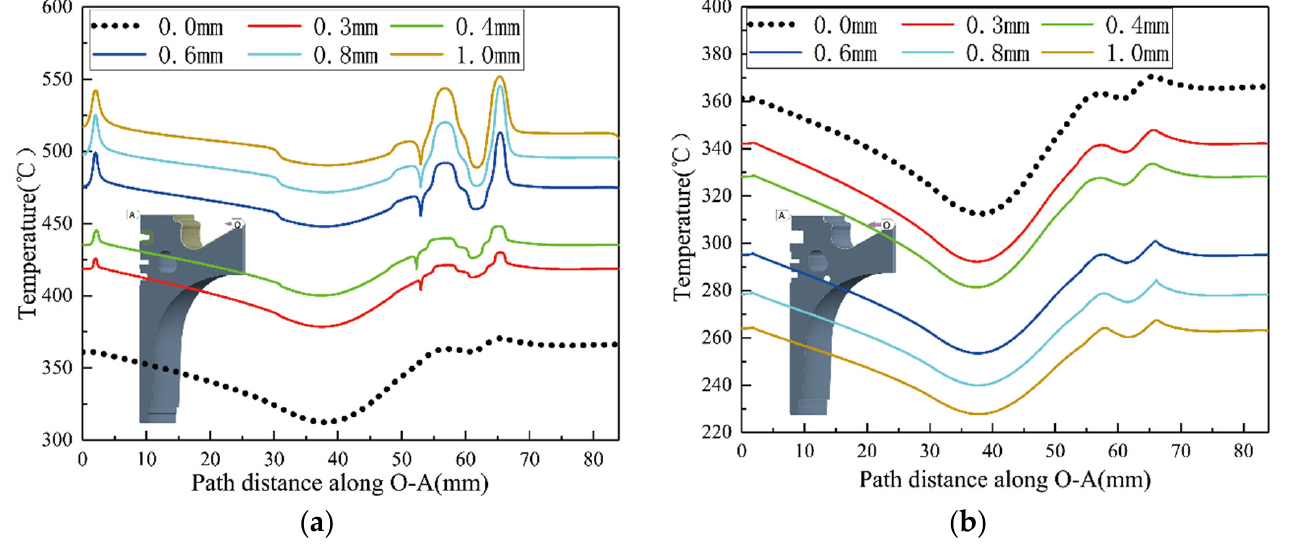
Figure 13. ( a ) Top surface-temperature distribution along O-A path distance; ( b ) substrate surface- temperature distribution along O-A path distance.